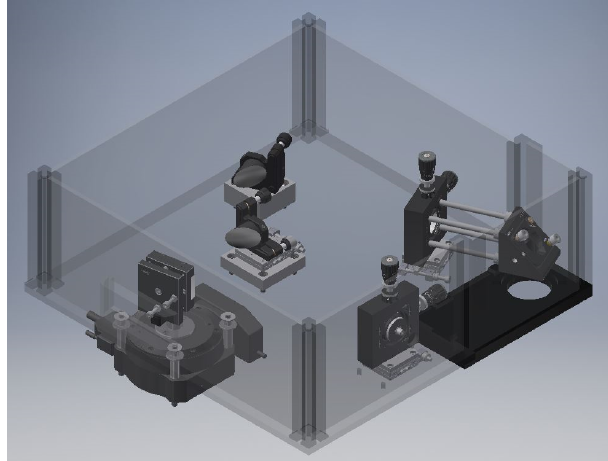
Figure 2. The optical setup of the first prototype of TuPS (bread- board 400mm ×